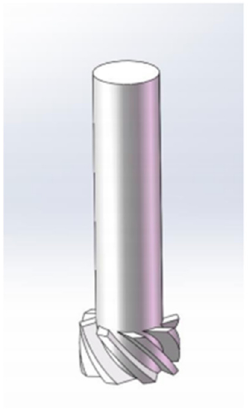
Figure 5. Swirl flame